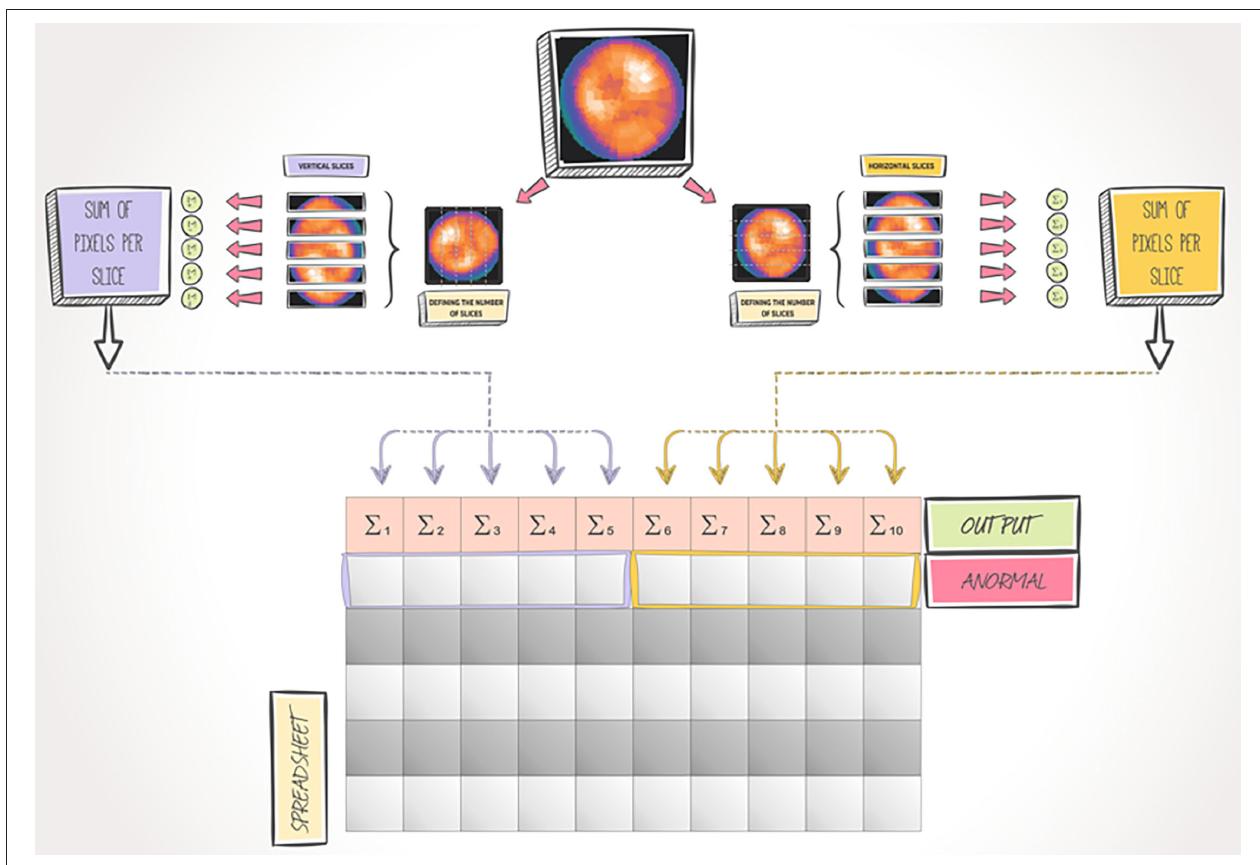
FIGURE 2 | Feature extraction